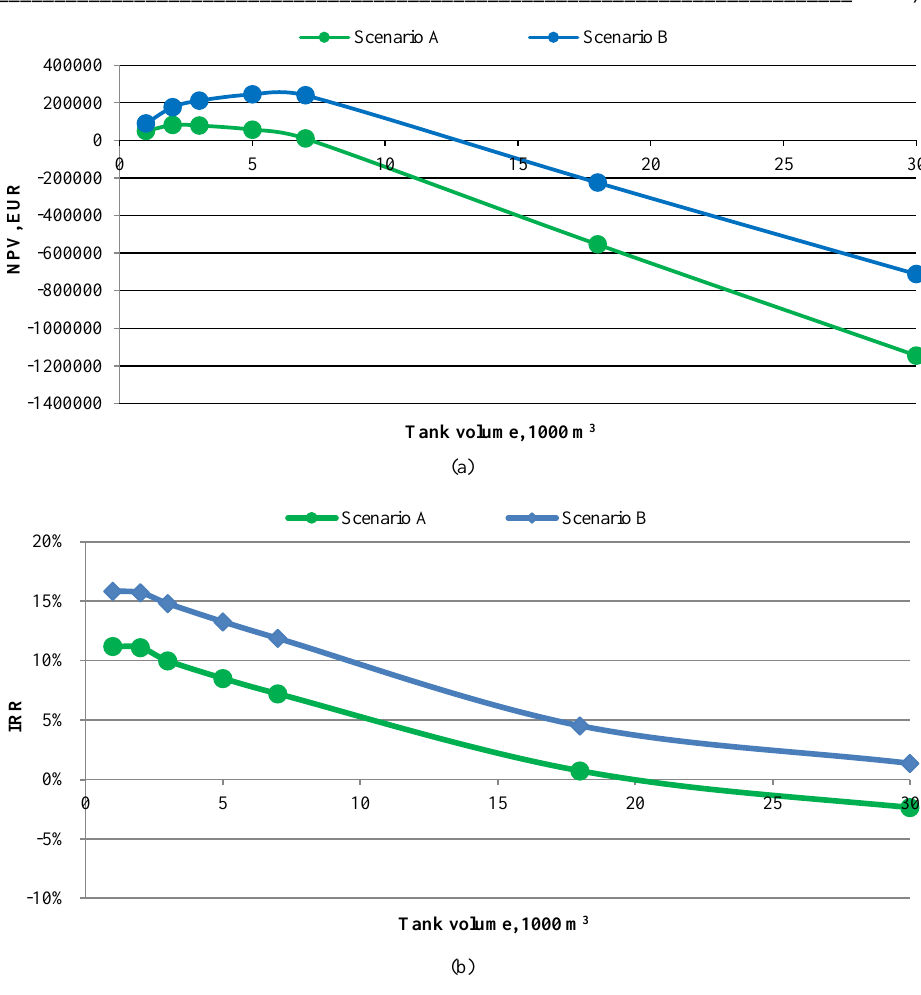
Fig. 7. Economic indicators (a) NPV and (b) IRR, based on heat storage